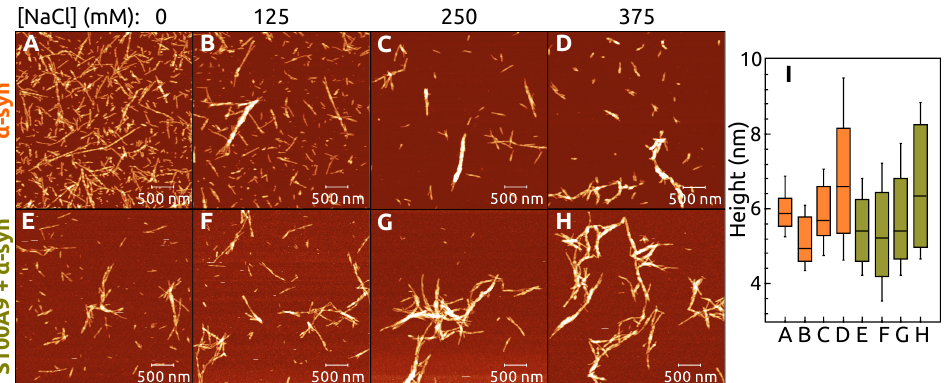
Figure 6. AMF images of α -syn aggregated without ( A – D ) and with ( E – H ) S100A9 in the presence of different concentrations of NaCl (additional to PBS): 0mM ( A , E ), 125mM ( B , F ), 250mM ( C , G ), and 375mM ( D , H ). Panel ( I ) shows the heights of fibrils in the mentioned conditions from ( A ) to ( H ). The boxes, lines inside them, and whiskers correspond to interquartiles, medians, and standard deviations of the height distribution, respectively. Protein solution: 70µM α -syn, 0 or 35µM S100A9, 50µM ThT, PBS, additional NaCl as mentioned,